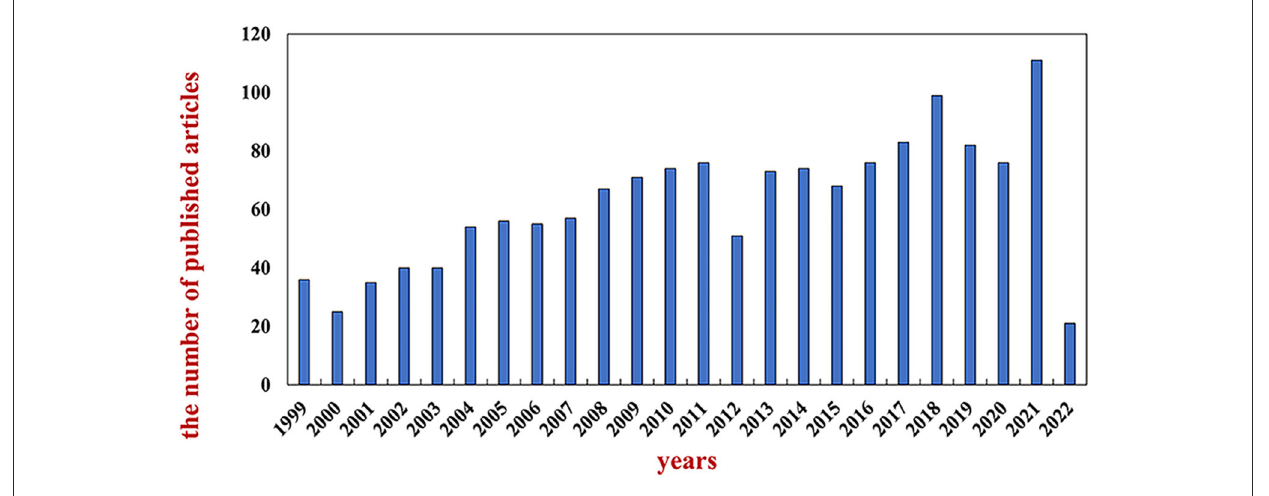
FIGURE1 Annual trend chart of